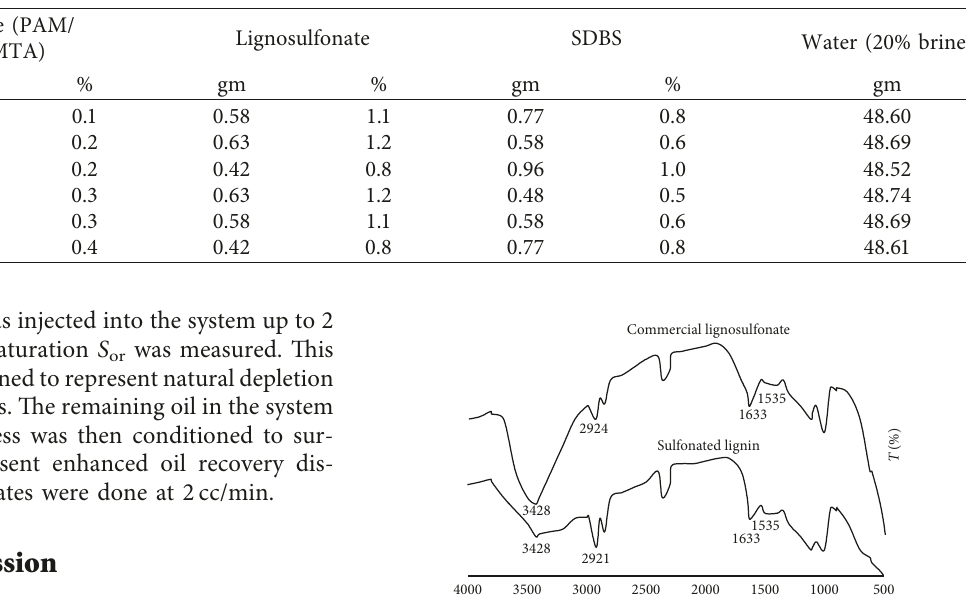
Table 1: Surfactant blends